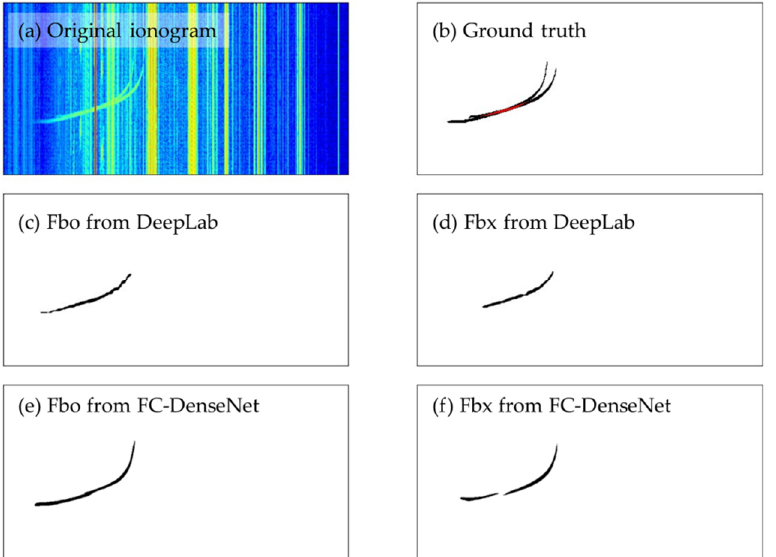
Figure 5. An example of the overlapping ordinary and extraordinary signals from the F2 layer: ( a ) the original ionogram; ( b ) the ground truth labeled in the original ionogram (black pixels are the non-overlapping part and red pixels the overlapping part of the signals); ( c , d ) the output of DeepLab for Fbo and Fbx, respectively; ( e , f ) the output of FC-DenseNet for Fbo and Fbx, respectively.